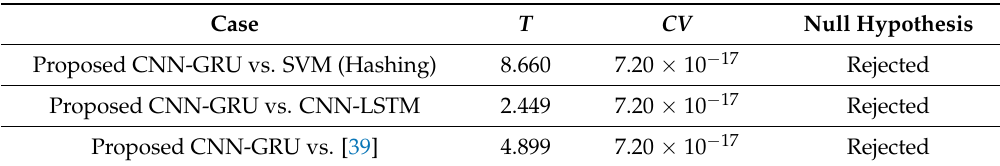
Table 20. Statistically significant T